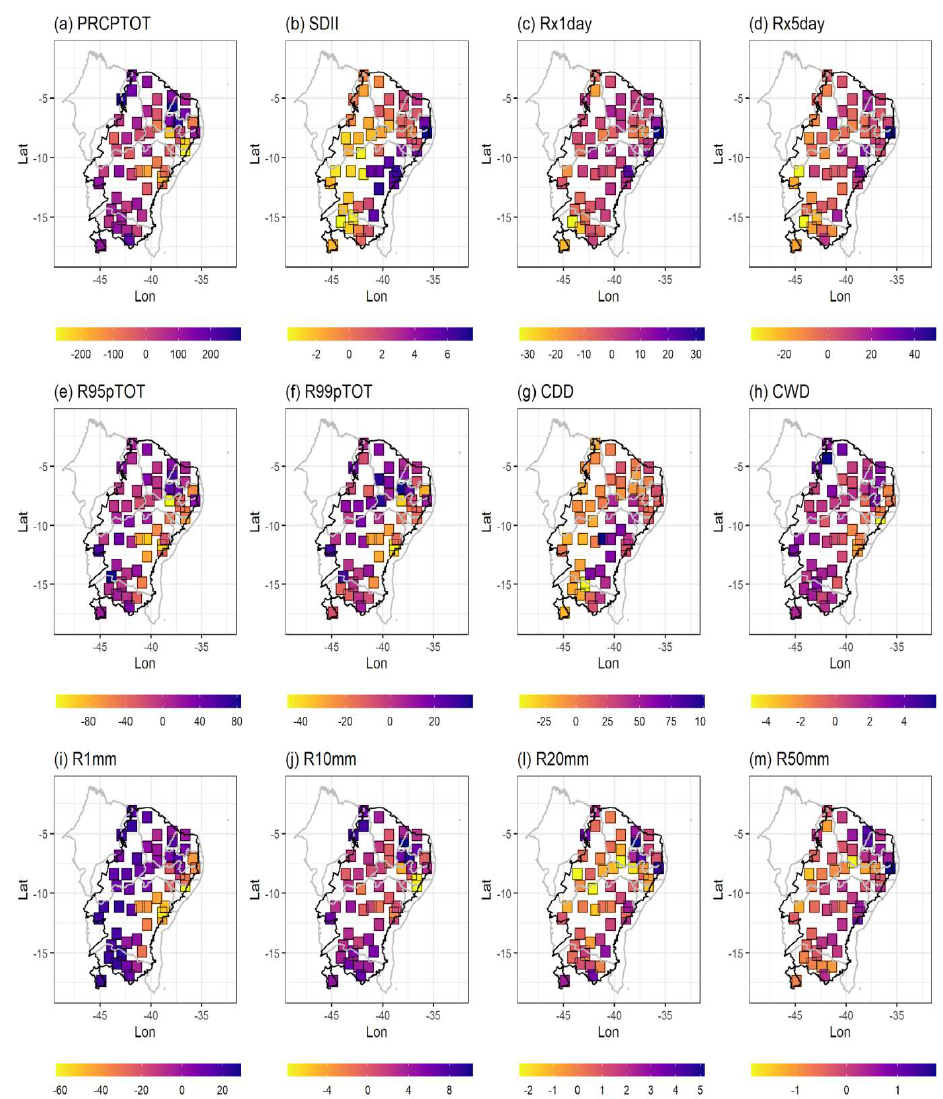
Figure 4. BIAS between climate indices derived from IMERG and rain gauges over a period of 21 years (2000–2020), ( a ) PRCPTPT, ( b ) SDII, ( c ) Rx1day. ( d ) Rx5day, ( e ) R95pTOT, ( f ) R99pTOT, ( g ) CDD, ( h ) CWD, ( i ) R1mm, ( j ) R10mm, ( l ) R20mm, ( m ) R50mm. The RMSE between the two data sources is shown in Figure 5. It is known that a lower value indicates a better ability of the IMERG product to accurately represent the climatic indices observed by rain gauges. The results were still satisfactory; the RMSE values were small, compared to the order of magnitude of the variables. Similar results were observed by [28], who evaluated the IMERG database for the San Francisco River Basin, which is located in the SAB. The SDII index, for example, follows the same pattern as in Figure 2b, where the east is not well represented, thus presenting higher RMSE values. A similar behavior occurred for R1mm, indicating that, in the east of the SAB, the